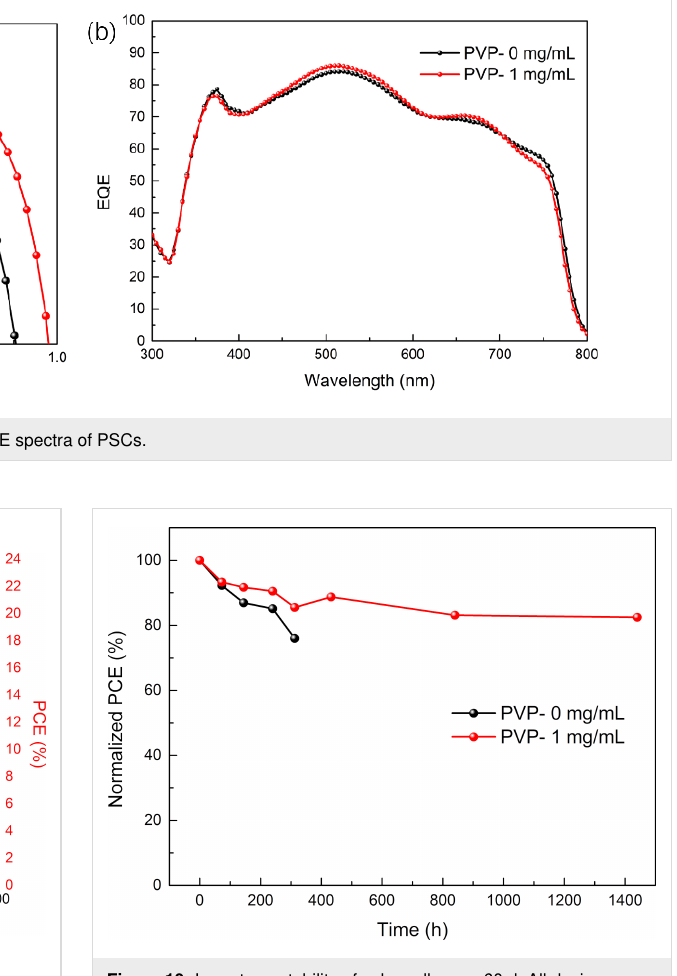
Figure 10: Long-term stability of solar cells over 60 d. All devices were stored in ambient environment (humidity less than 10%, room temper-